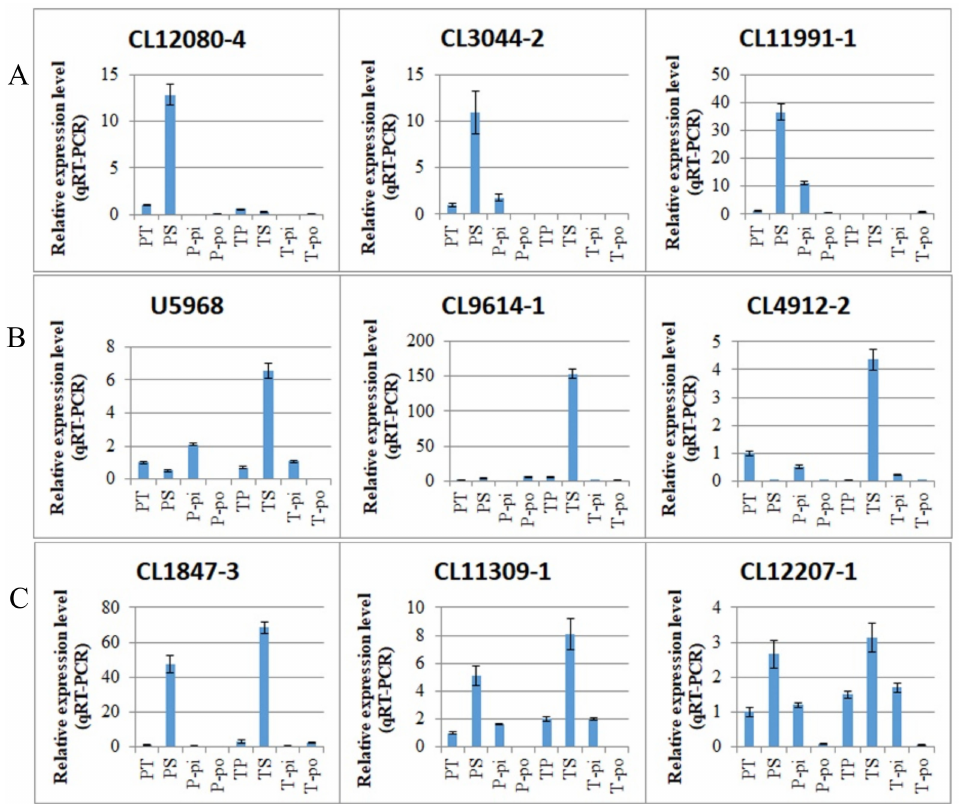
Figure 6. Expression patterns of DEGs upregulated in the PS vs. PT and/or TS vs. TP comparisons detected by qRT-PCR. ( A ) Expression patterns of DEGs upregulated specifically in the PS vs. PT comparison which were expressed highly in PS pollination; ( B ) Expression patterns of DEGs upregulated specifically in the TS vs. TP comparison which were expressed highly in TS pollination; ( C ) Expression patterns of DEGs upregulated in the PS vs. PT and TS vs. TP comparisons which were expressed highly in PS and TS pollination. PT, pistils of pin after cross-pollination. PS, pistils of pin after self-pollination. P-pi, pin pistils without pollination. P-po, pin pollen. TP, pistils of thrum after cross-pollination. TS, pistils of thrum after self-pollination. T-pi, thrum pistils without pollination. T-po, thrum